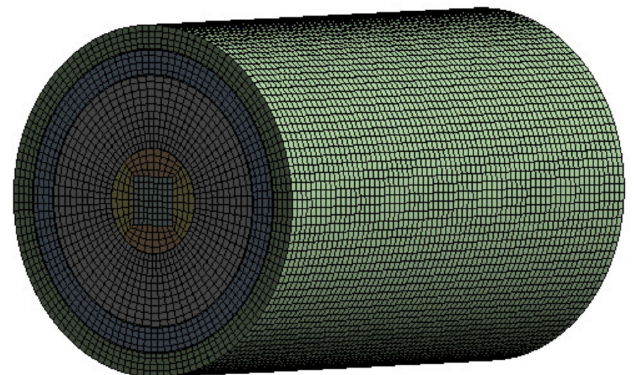
Figure 8. Geometric interference meshing.